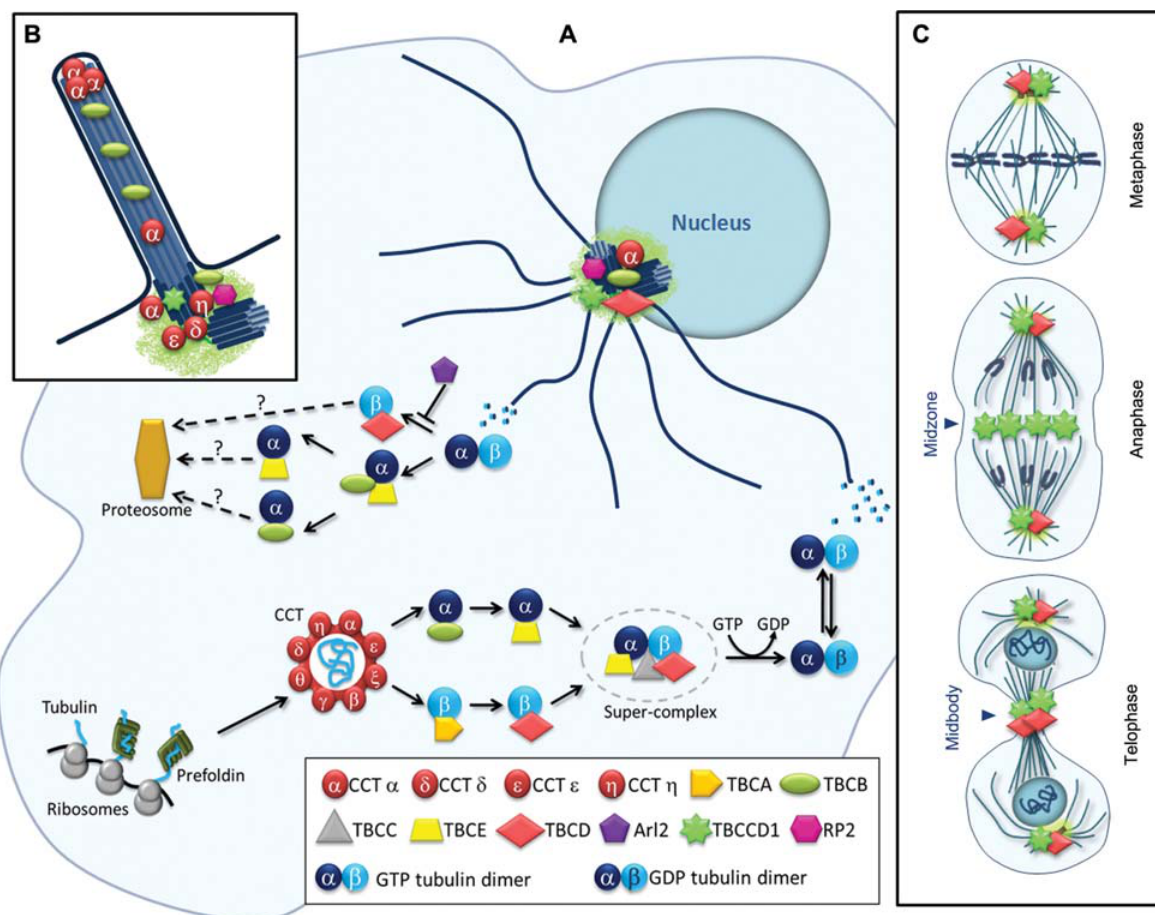
Figure 2 The tubulin folding pathway and related proteins in several cellular contexts. (A) Schematic representation of the tubulin folding and native dimer disassembly pathways (adapted from 39). The maturation of tubulin is a complex multistep process that culminates in the release of a / b -tubulin dimers in a GTP form and thus competent to polymerize into microtubules. Native dimers can be dissociated by TBCB, TBCD and TBCE. TBCB and TBCE form a complex and cooperate in the dissociation process. In (A) the localization of some members of these pathways and related proteins at the centrosome is also represented. (B) Representation of the cilium and basal body localizations of CCT subunits, TBCB, RP2 and TBCCD1. (C) Representation of the TBCD and TBCCD1 localizations during mitosis. These proteins are visible in the centrosome throughout the cell cycle, being TBCCD1 also identified in the midzone of the mitotic spindle. In late mitosis, TBCD and TBCCD1 localize in the